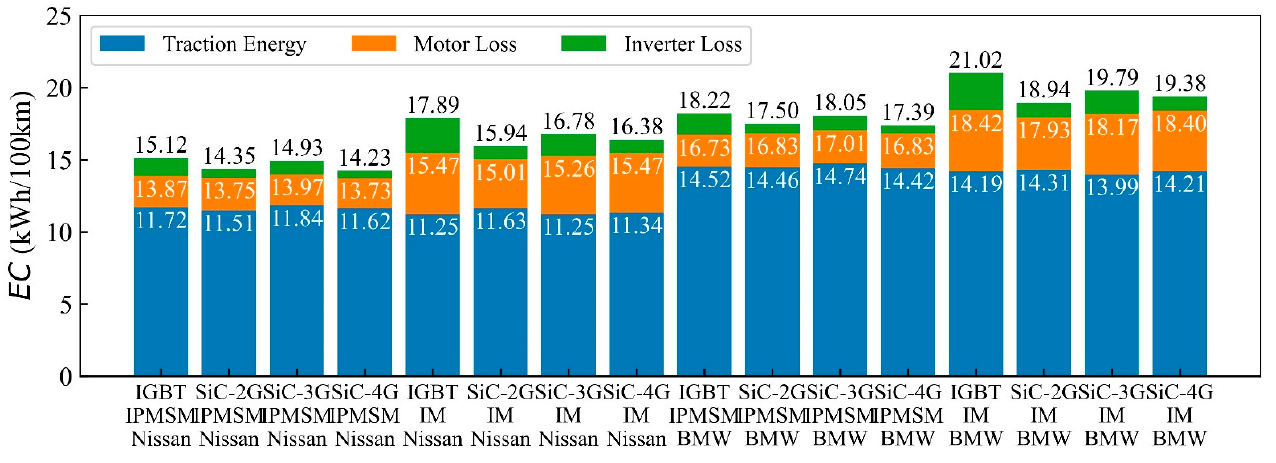
Figure 3. Energy consumption of each experimental case.